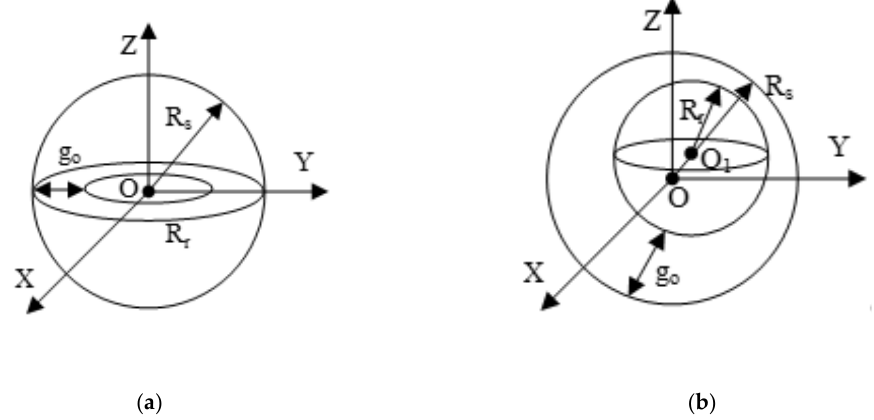
Figure 21. Rotor eccentric motion diagram; ( a ) Without eccentricity; ( b ) With eccentricity.